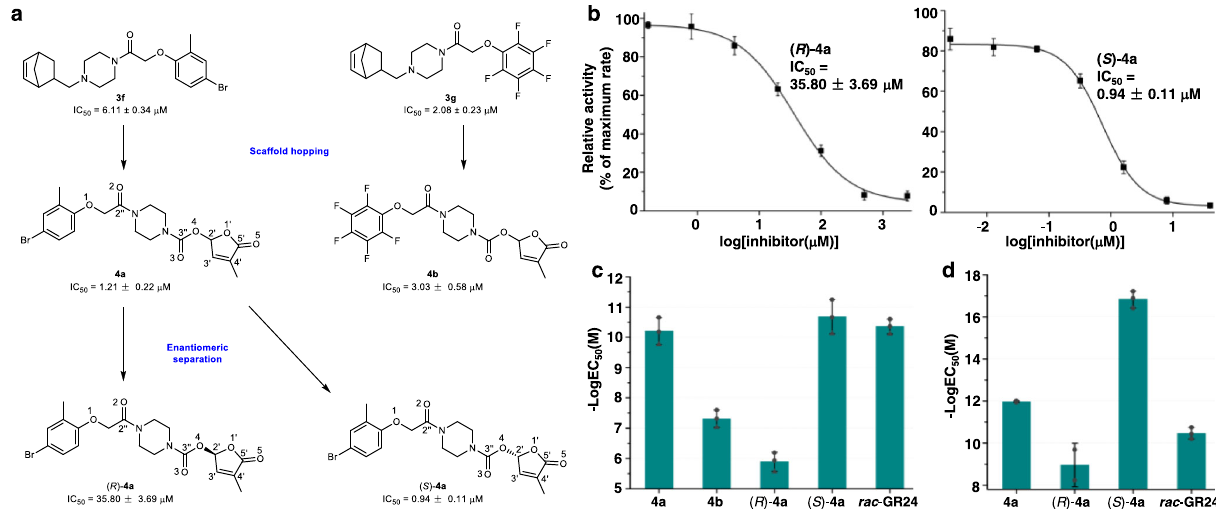
Fig. 2 Rational optimization yields the discovery of highly potent seed germination stimulants for P. aegyptiaca and S. hermonthica . a Structural optimization process of compounds 3f and 3g . b Competitive ShHTL7 inhibitory activity curve via YLG assay under different concentrations of ( R )- 4a and ( S )- 4a , error bars mean SD ( n = 3 biologically independent experiments). c The P. aegyptiaca germination EC 50 values of compounds 4a , 4b , ( R )- 4a , ( S )- 4a , and rac -GR24, error bars mean SD ( n = 3 biologically independent experiments). d The S. hermonthica germination EC 50 values of compounds 4a , ( R )- 4a , ( S )- 4a , and rac -GR24, error bars mean SD ( n = 2 or 3 biologically independent